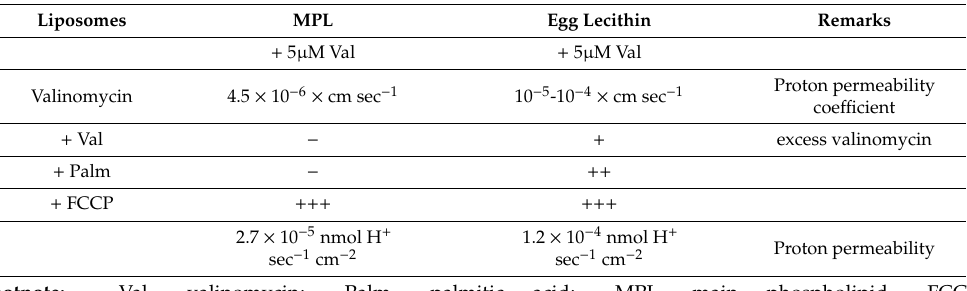
Table 13. Proton